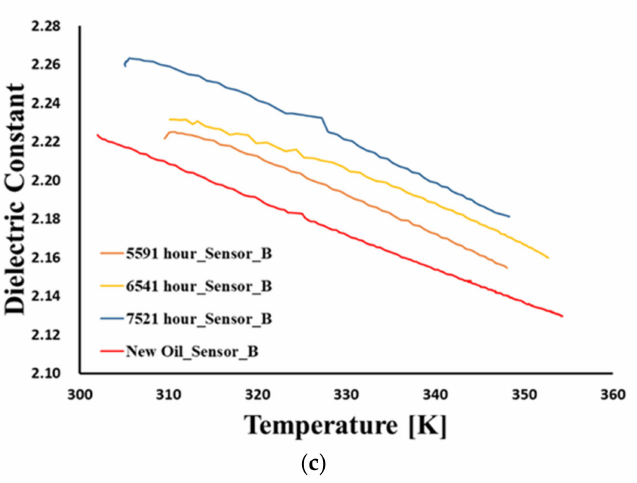
Figure 8. The oil sensor signals of varnish contamination. ( a ) Sensor signals of kinematic viscosity. ( b ) Sensor A signals of dielectric constant. ( c ) Sensor B signals of dielectric constant.